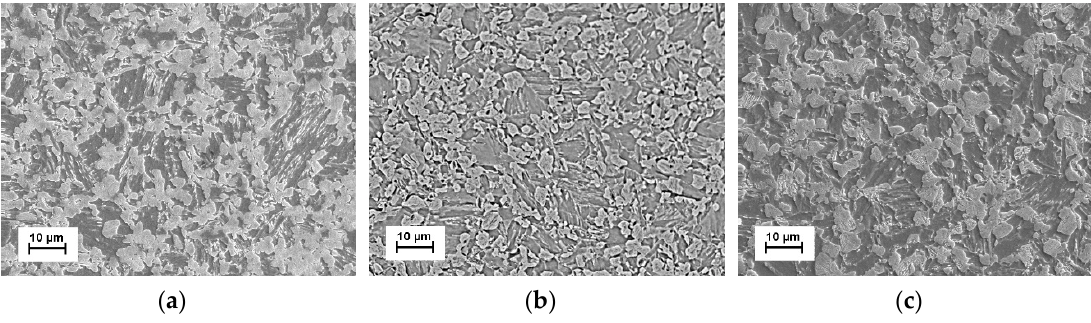
Figure 6. ICHAZ microstructure: ( a ) t 8/5 = 2.5 s; ( b ) t 8/5 = 15 s; ( c ) t 8/5 = 30 s (M = 1000×, 2% HNO 3 ).